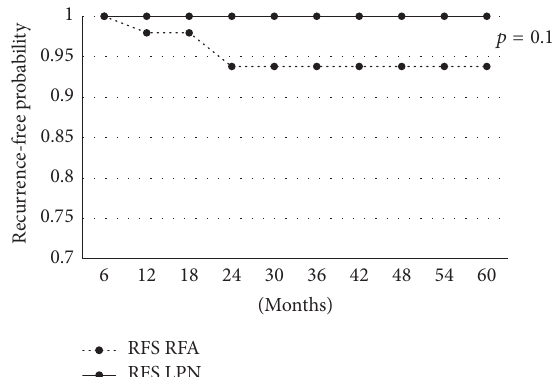
Figure 2: Comparison of recurrence free survival. Five-year recurrence-freesurvivalswerecomparedbetweentheRFA-RPNand RPN